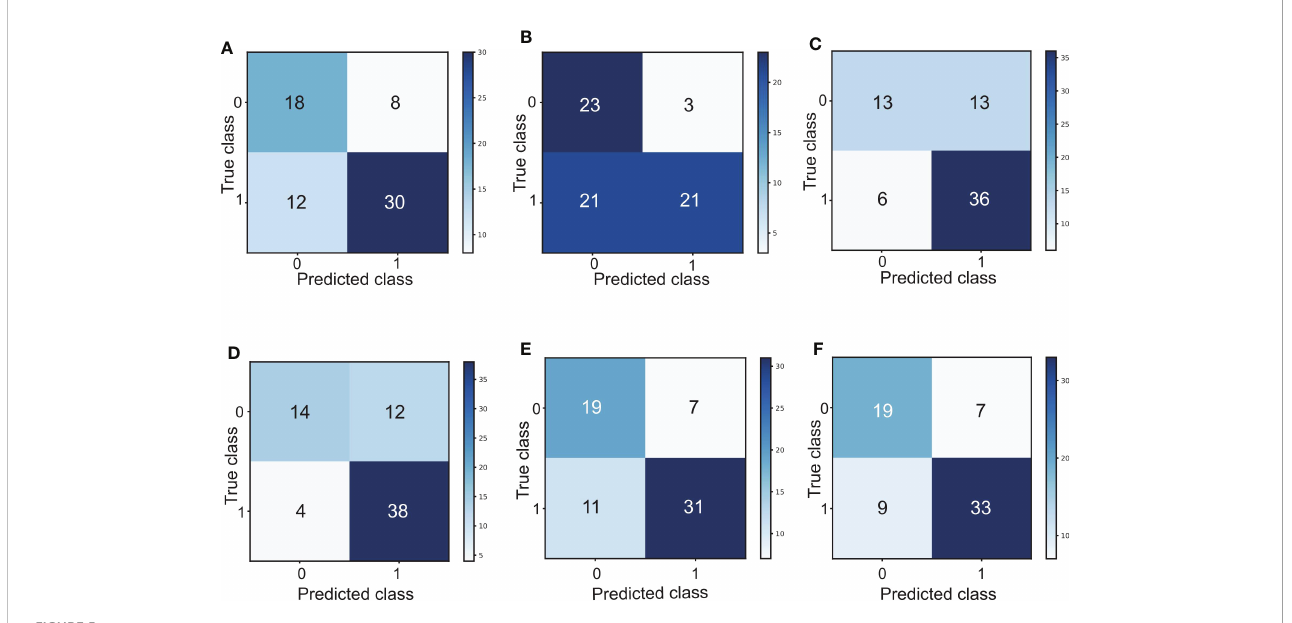
FIGURE 5 (A) Confusion matrix for predicting lung cancer relapse in patients based on the FR + -CTC count. (B) Confusion matrix for predicting lung cancer relapse in patients based on the LC. (C) Confusion matrix for predicting lung cancer relapse in patients based on the dNLR. (D) Confusion matrix of the FR + -CTC count combined with the LC to predict lung cancer relapse in patients. (E) Confusion matrix of the FR + -CTC count combined with the dNLR to predict lung cancer relapse in patients. (F) Confusion matrix of the FR + -CTC count combined with the LC and dNLR to predict lung cancer relapse in patients. 0: relapse; 1: no